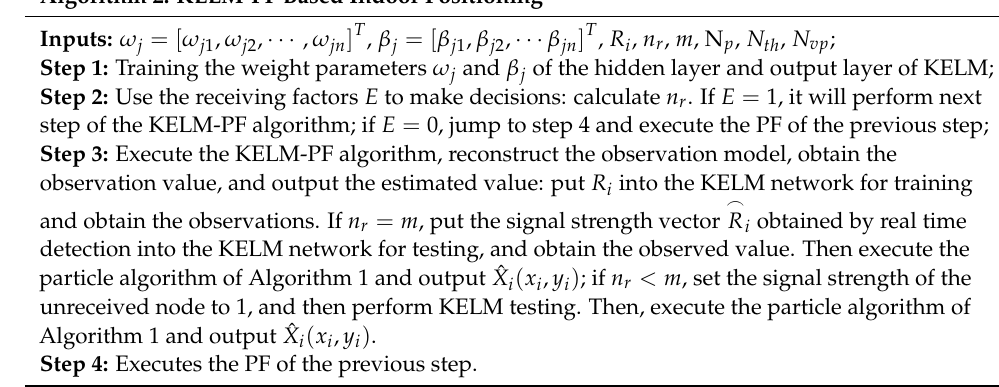
Algorithm 2. KELM-PF Based Indoor